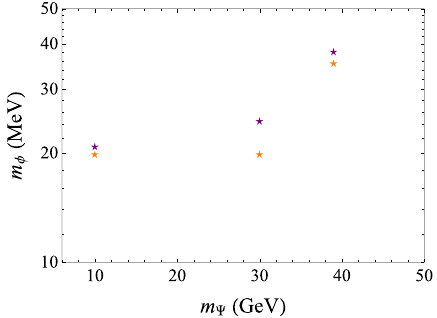
Fig. 3 The velocity-weighted self-scattering cross section per unit SIDM mass (cid:10) σ T v r (cid:11) / m (cid:3) as a function of the mean relative velocity (cid:10) v r (cid:11) at given SIDM masses m (cid:3) = 10, 30 and 39 GeV. The solid curves for each SIDM mass are values of (cid:10) σ T v r (cid:11) / m (cid:3) , with the orange one, purple one corresponding to the lower bound, upper limit of m φ ’s range being taken, respectively. The averaged cross section per unit SIDM mass is taken as (cid:10) σ T v r (cid:11) /( (cid:10) v r (cid:11) m (cid:3) ) (cid:4) 1 cm 2 /g at dwarf and galaxy scales and